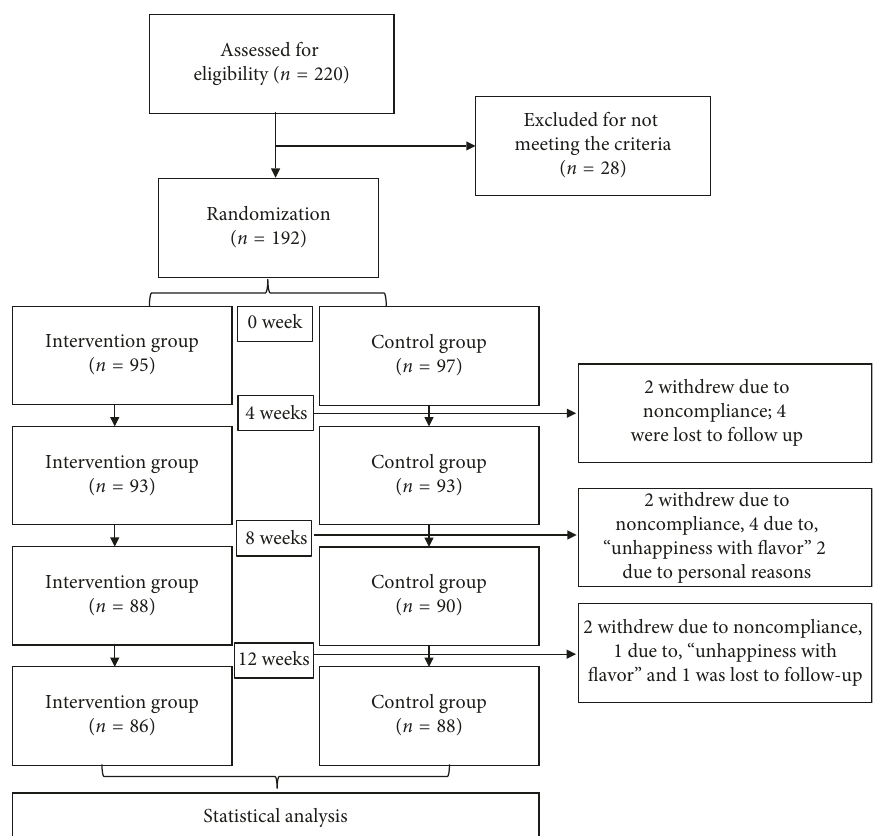
Figure 1: Flowchart of study